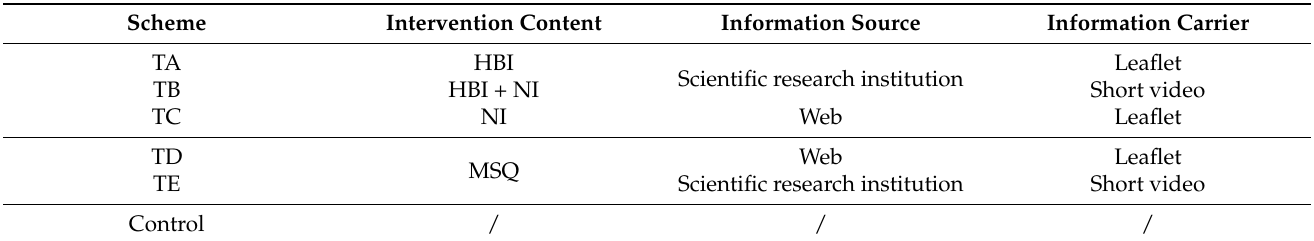
Table 1. Description of treatment